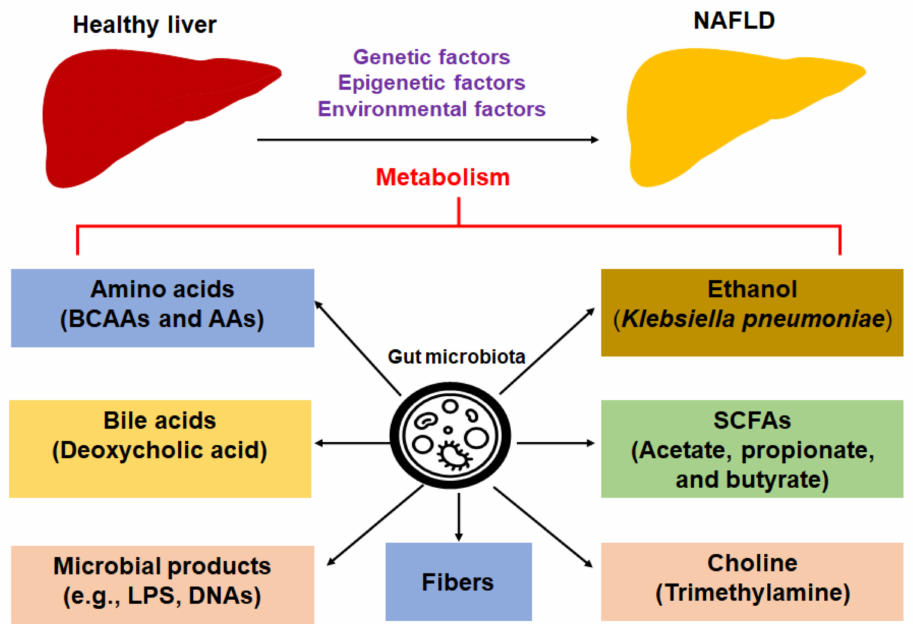
Figure 1. Dietary metabolites or metabolites derived from gut microbiota impact the progression of NAFLD. Abbreviations: AAA, aromatic amino acid; BCAA: branched-chain amino acid; LPS, lipopolysaccharide; NAFLD, nonalcoholic fatty liver disease; SCFAs, short-chain fatty